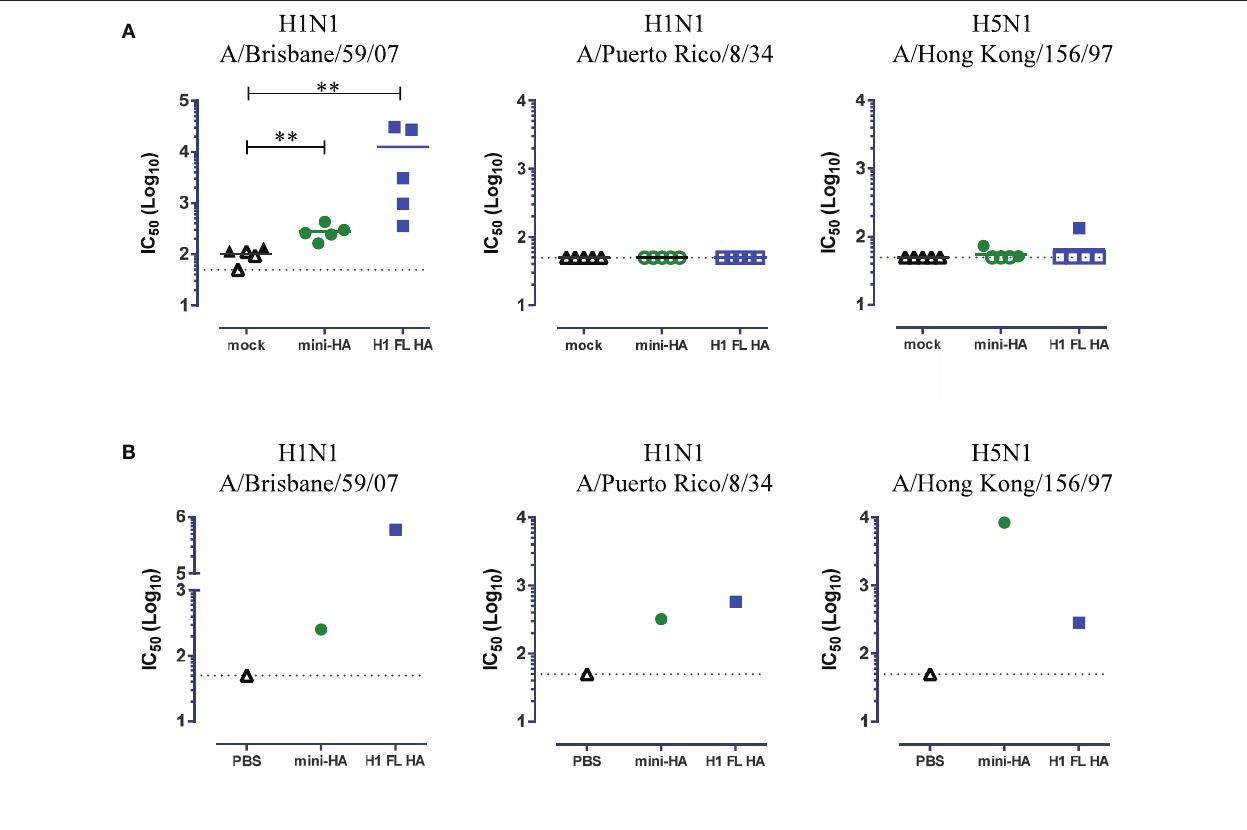
FIGURE 3 | Cross-neutralization detected in concentrated serum samples. Neutralization of H1N1 A/Brisbane/59/07, H1N1 A/PuertoRico/8/34 and H5N1 A/HongKong/156/97 as measured by pseudoparticle VNA assay. Results of immunization with 103 nmol antigen shown. Serum samples were taken 1 day prior to influenza challenge. Results are shown for individual mice (A) , or mouse samples were pooled per immunization regimen and antibodies were purified and concentrated (B) . Solid lines indicate the group means. Closed symbols represent positive values, see material and methods. Dashed lines indicate LOD. Asterisks indicate statistical significant differences between regimens (** p < 0.01). No statistical test was done on the single replicates in (B)